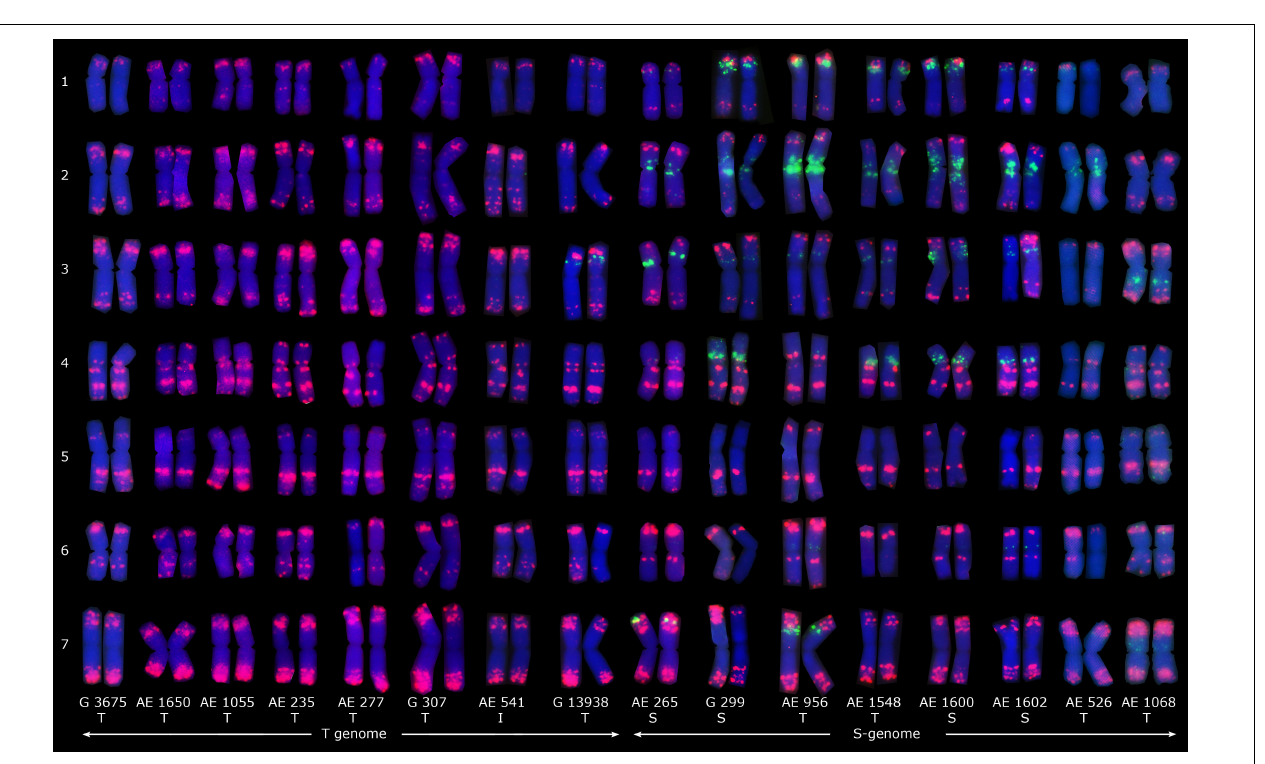
FIGURE 4 | Distribution patterns of (GAA) 10 (green) and pTa535-1 (red) probes on the mitotic metaphase chromosomes of sixteen Ae. tauschii accessions. Types of spike morphology (S, subsp. strangulata ; T, subsp. tauschii ; and I, intermediate) has also been indicated.